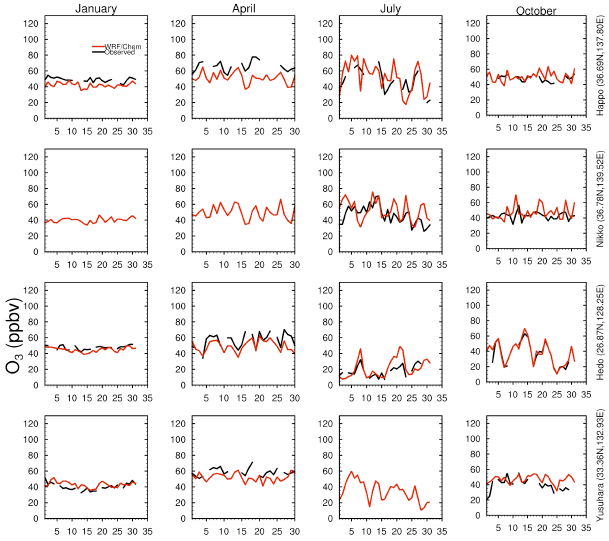
Fig. 4b. Comparison of observed (black) and simulated (red) daily mean O 3 mixing ratios (ppbv) at, Happo, Nikko, Hedo, and Yusuhara. Observed hourly values were taken from EANET data for 2000 and averaged when there was no missing value in 24-hours.